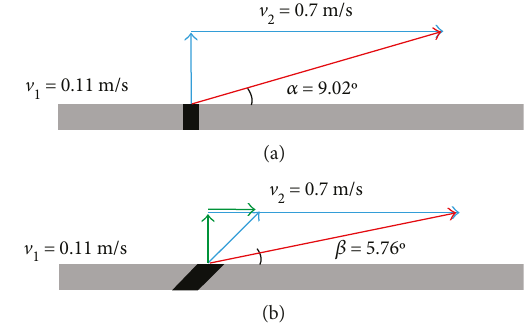
Figure 4: E ff ect of gas injection direction on tracer fl ow direction. (a) The jet direction was at an angle of 45 ° to the surface of the fl at, and (b) was 90 ° . Flow speed ( v ) =0.7m/s, and mixed gas 1 ) outlet speed ( v 2